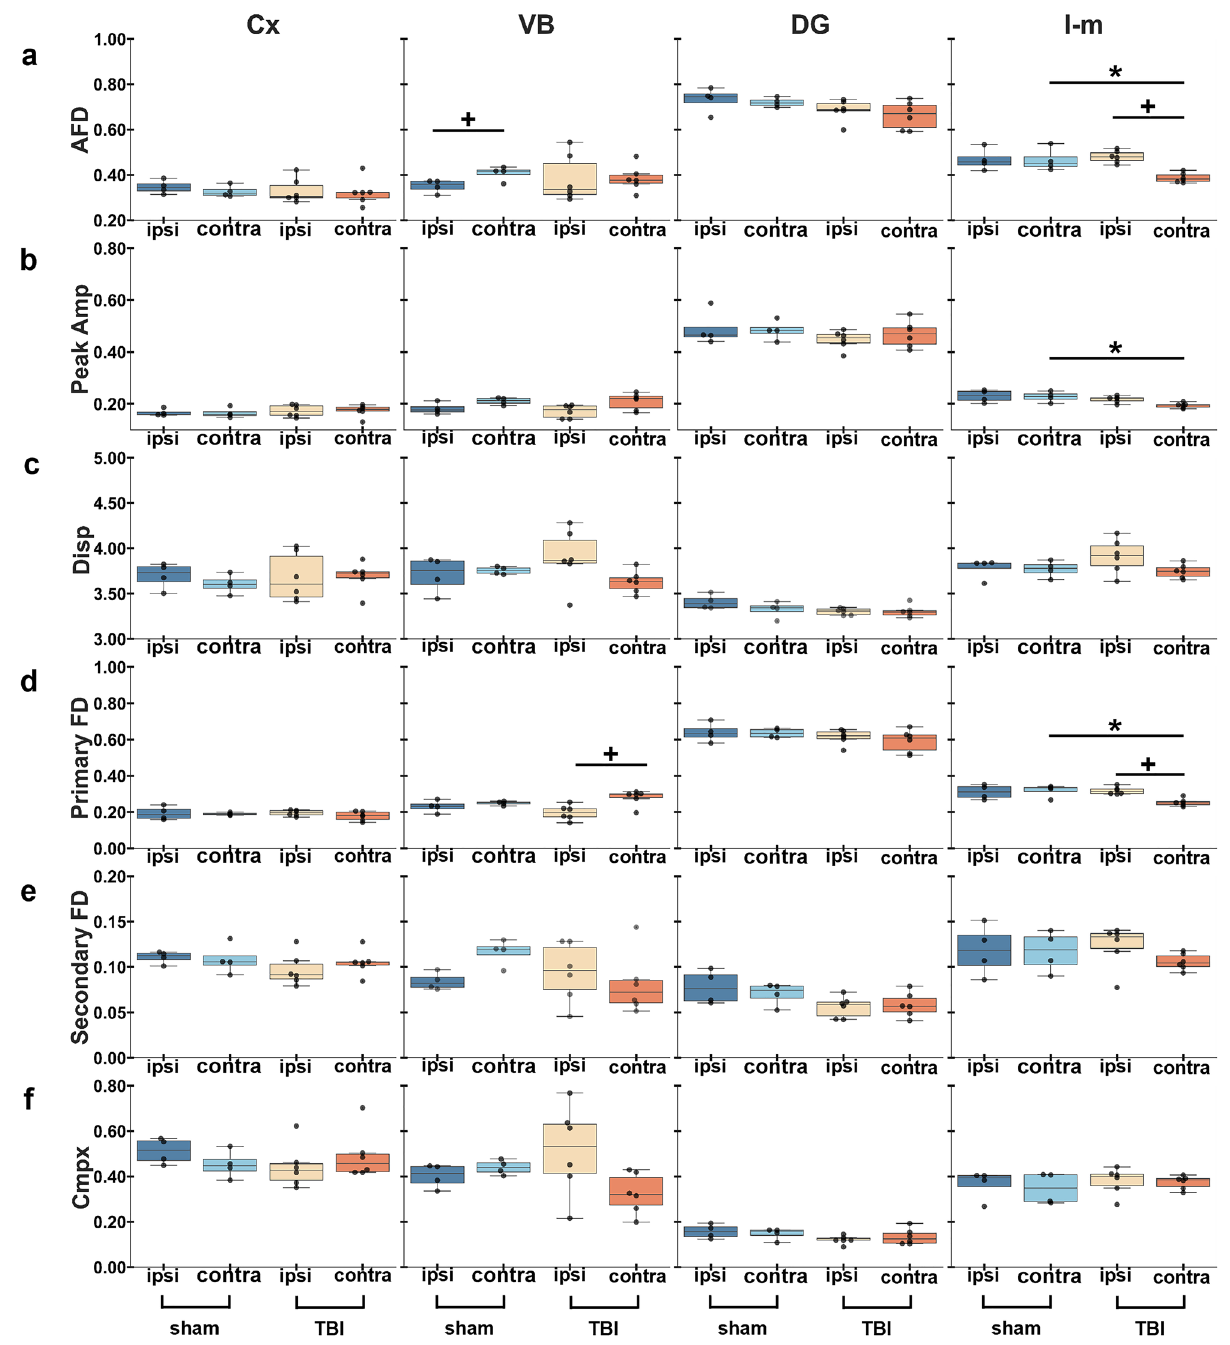
Figure 6. ROI-based analysis of fixel-based metrics in grey matter areas. Results are shown as minimum, lower quartile, median, upper quartile and maximum, and paired t-test comparing ipsi- and contralateral sides within animals ( *q < 0.05) or unpaired t-test comparing the same hemisphere between sham-operated and TBI rats ( + q < 0.05) which are FDR corrected. Abbreviations: AFD, apparent fiber density; Amp, amplitude; Cx, perilesional cortex; Cmpx, complexity; DG, dentate gyrus; Disp, dispersion; FD, fiber density; l-m, stratum lacunosum-moleculare; VB, ventrobasal